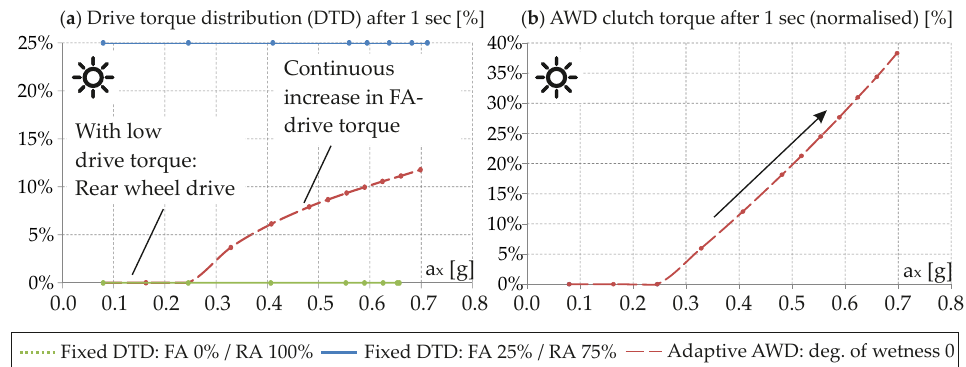
Figure 9. “Power On Cornering“ maneuver ( R = 60m , a y 0 =6m/s 2 ) on dry road ( µ max = 1.0): ( a ) drive torque distribution (DTD) after 1s; ( b ) normalised AWD clutch torque after